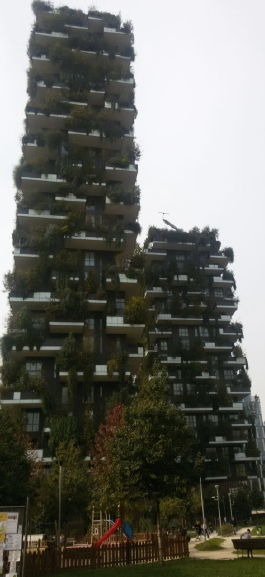
Figure 3. Vertical forest in Milan (Italy).